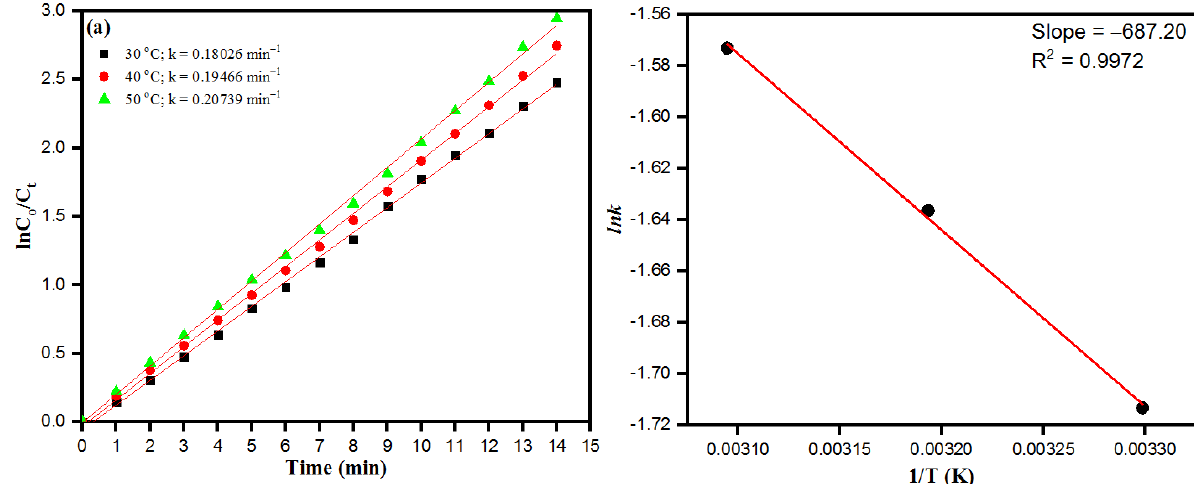
Figure 11. (a) Plot of lnC o /C t vs time for the reduction of CR as of function of temperature. ( b ) Arrhenius plot for the calculation of activation energy (Ea). (Experimental conditions: (CR) = 0.5 × 10 −4 M, (NaBH 4 ) = 1.0 × 10 −3 M, PdNPs = 4 mg).